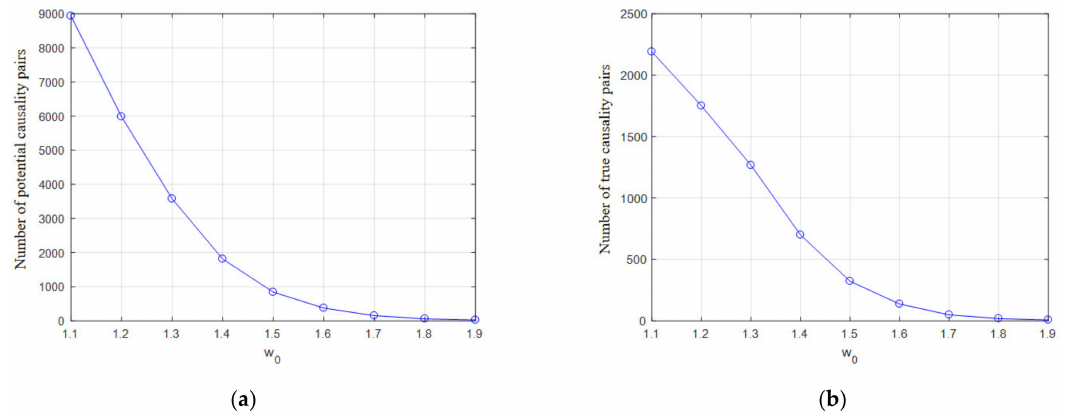
Figure 12. Graph of the number of candidate causality pairs and true causality pairs as a function of w 0 . ( a ) The relationship between the number of potential causality pairs and w 0 ; ( b ) the relationship between the number of true causality pairs and w 0